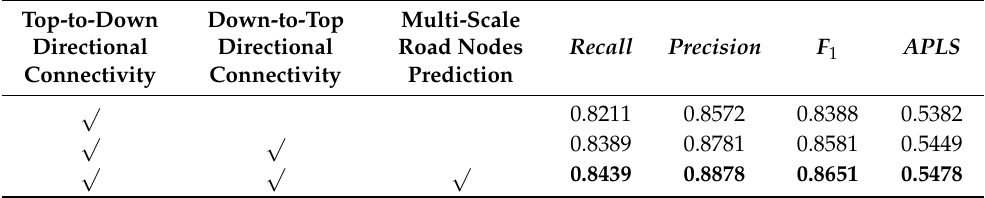
Table 4. Ablation experimental results of different part on DeepGlobe dataset.